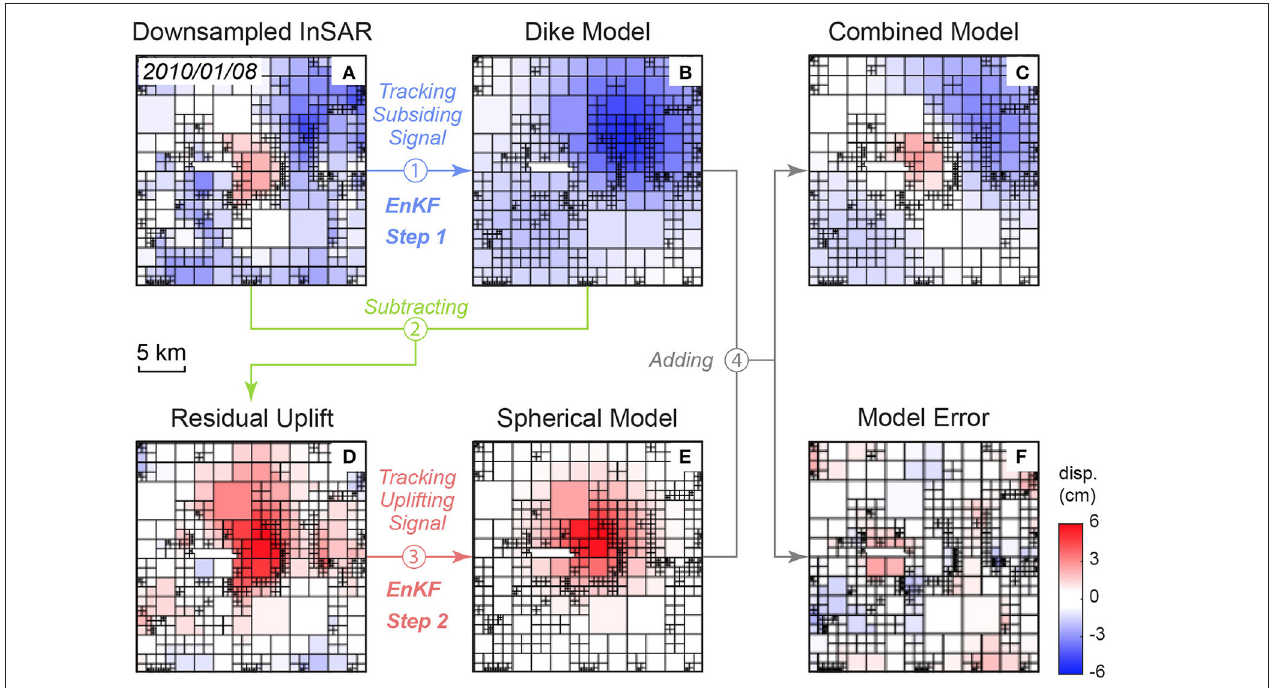
FIGURE 2 | Workflow of the two-step data assimilation with the downsampled InSAR data. (A) Downsampled InSAR, (B) , Dike model, (C) combined model, (D) residual uplift, (E) spherical model, (F) model error.